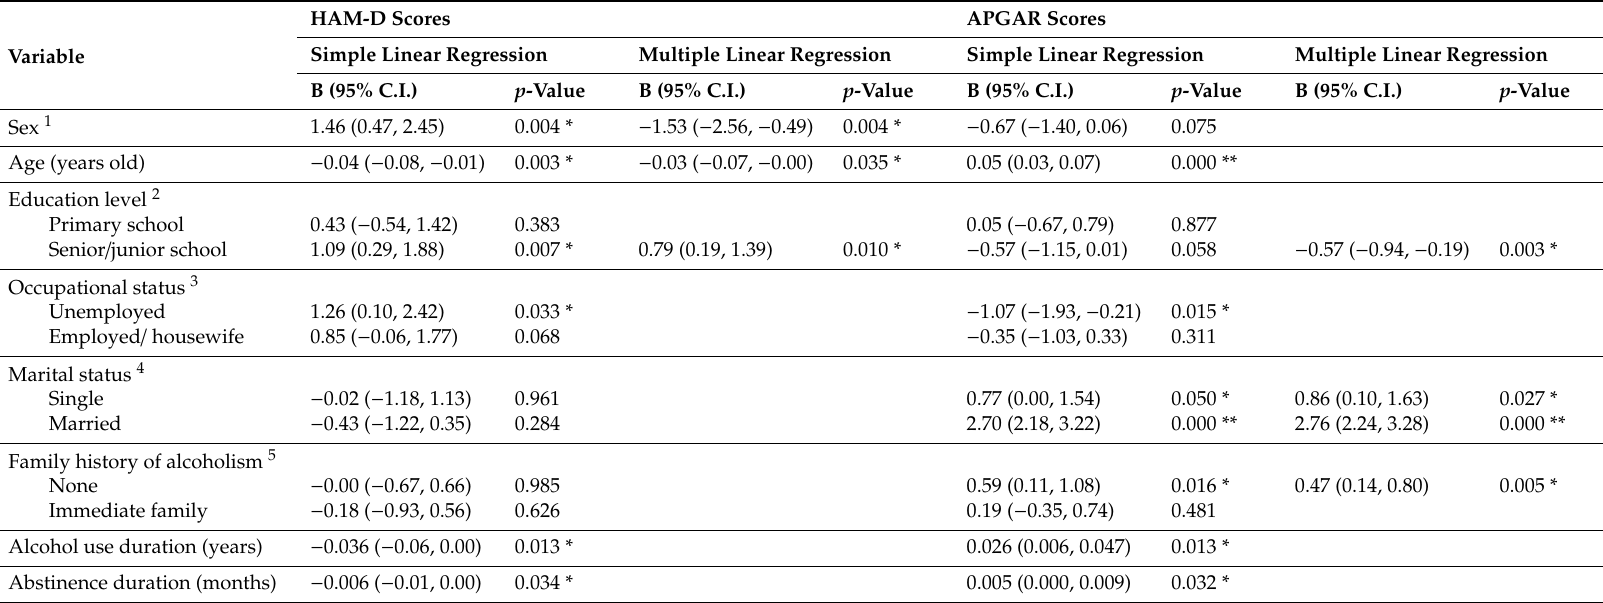
Table 3. The evaluation of Hamilton depression rating scale (HAM-D) scores; adaptability, partnership, growth, a ff ection, resolve (APGAR) scores; and LT patients’ characteristics: Univariable and multivariable